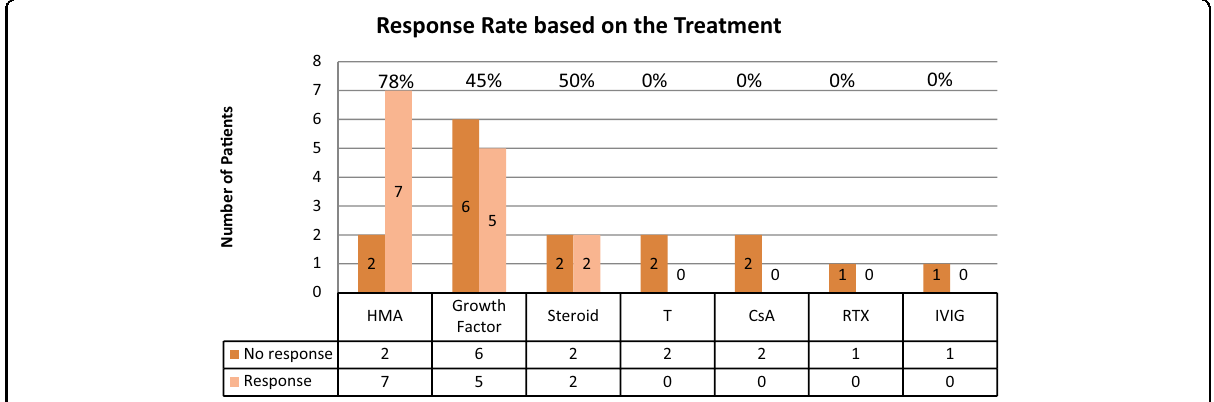
Fig. 1 Disease response rate (RR). Number and percentage of responders based on the treatment types. HMA hypomethylating agents, T testosterone, CsA cyclosporin, IVIG intravenous immunoglobulin, RTX